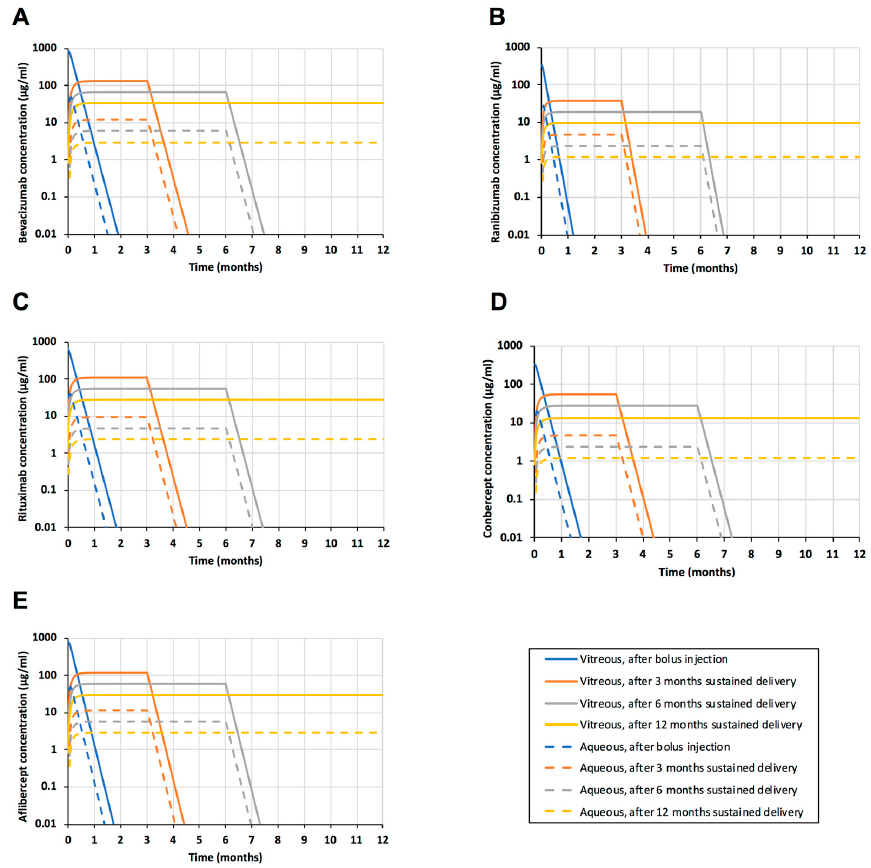
Figure 5. Simulations of intravitreal sustained release systems of bevacizumab ( A ), ranibizumab ( B ), rituximab ( C ), conbercept ( D ), and aflibercept ( E ). Simulated protein drug concentrations in the vitreous (solid lines) and aqueous humor (dashed lines) are shown. Simulations show intravitreal bolus injection (blue lines), and sustained delivery for 3 months (orange lines), 6 months (grey lines) and 12 months (yellow lines).